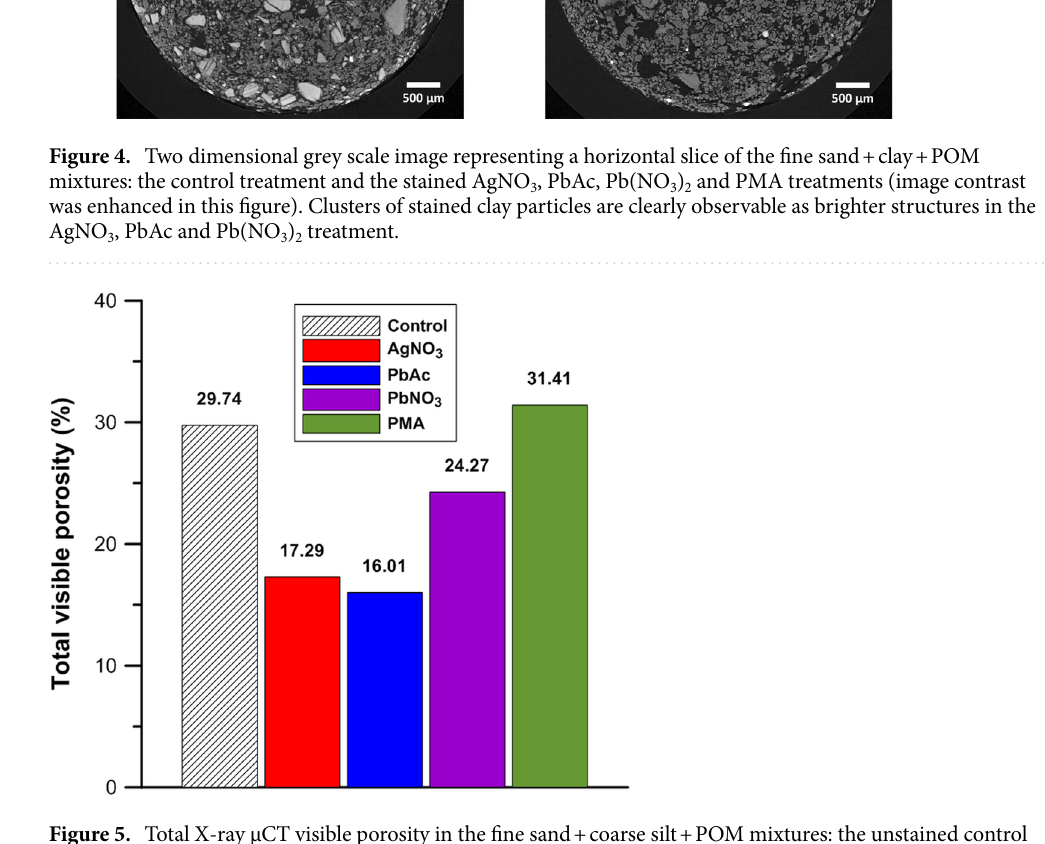
Figure 5. Total X-ray µCT visible porosity in the fine sand + coarse silt + POM mixtures: the unstained control treatment (black) and the stained AgNO 3 (red), PbAc (blue), Pb(NO 3 ) 2 (purple) and PMA (green)